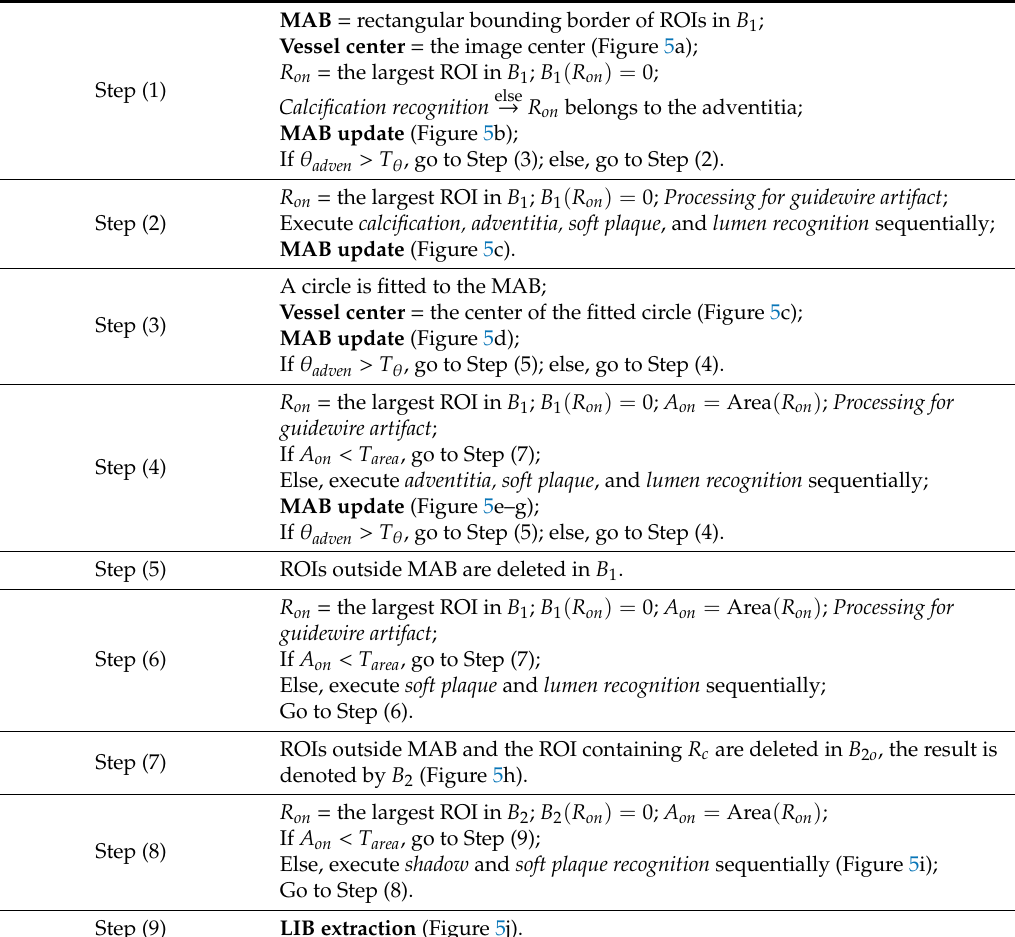
Table 1. The workflow of the region of interest (ROI) assignment